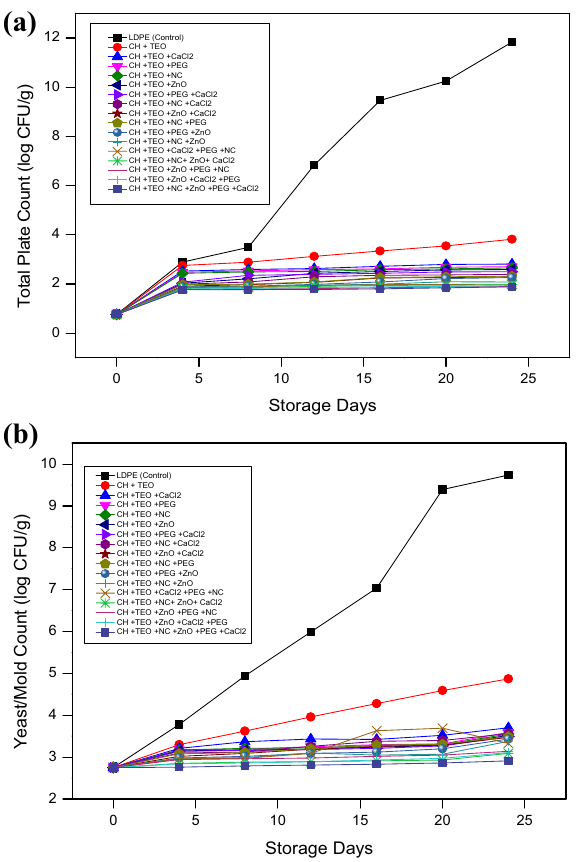
Figure 5. ( a ) Effect of different chitosan-based films and storage days on total plate count (log cfu/g) of collard greens. ( b) Effect of different chitosan-based films and storage days on yeast and mold count (log cfu/g) of collard greens.